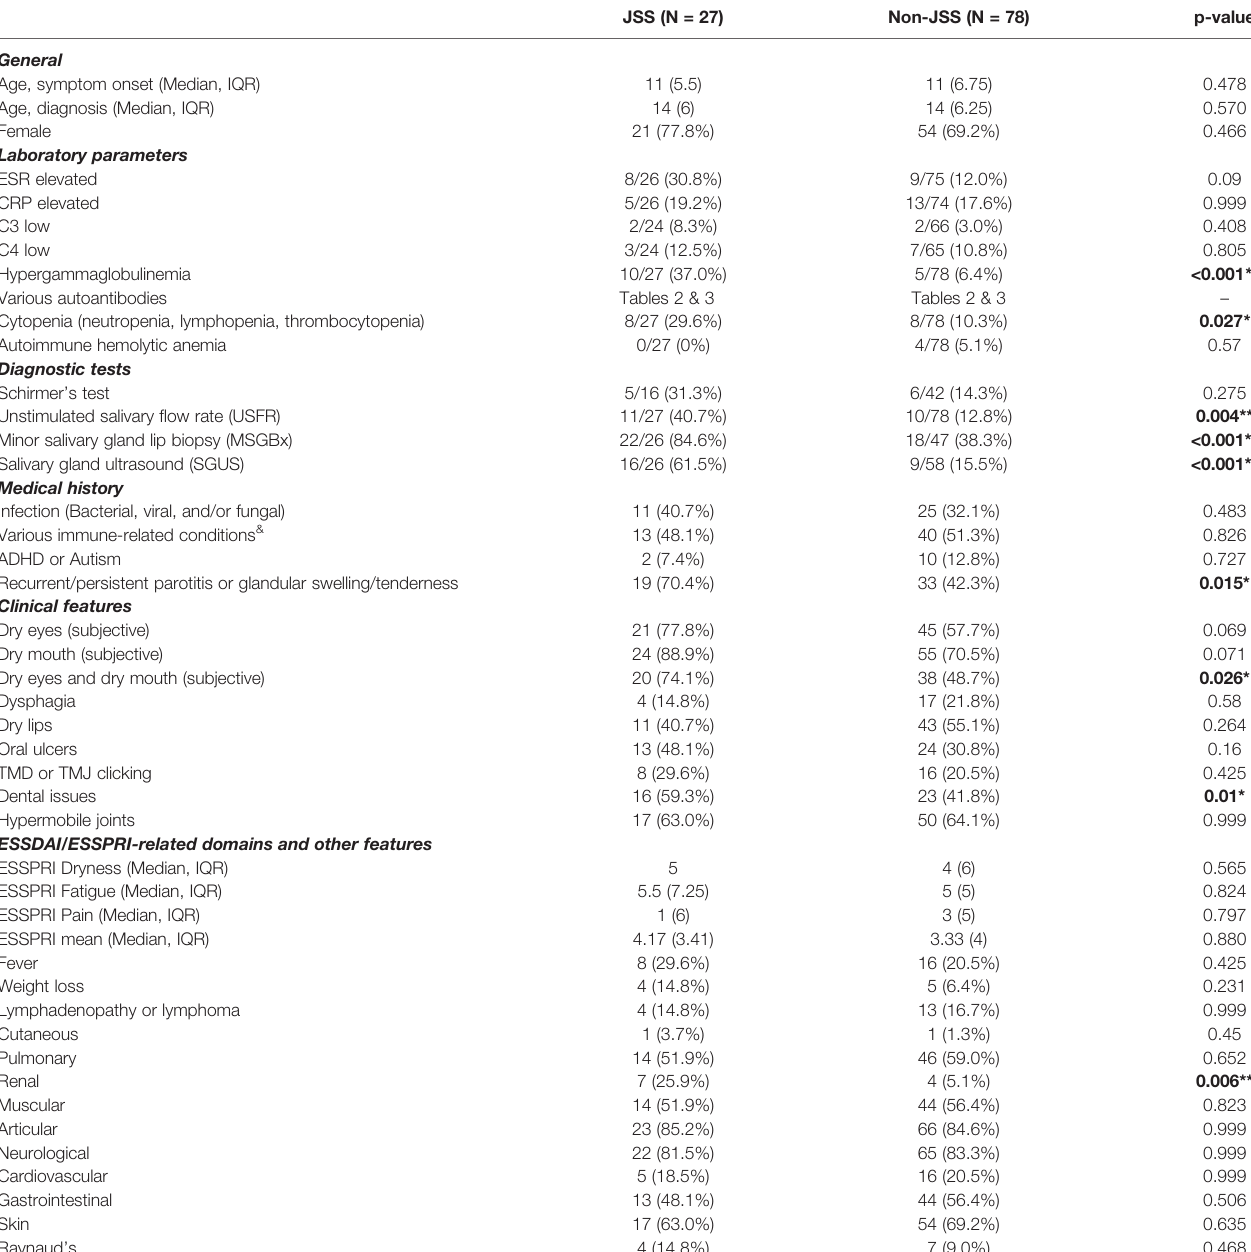
TABLE 1 | Demographic, clinical, and laboratory characteristics of the UF pediatric study cohort